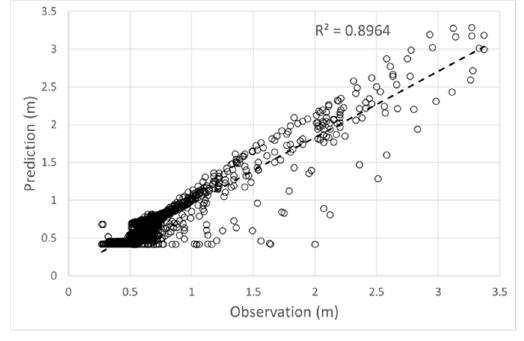
Scatter plot results Figure 10. Waterlevel prediction by deep neural networks (Gurodigital station). ( a ) Vanilla ANN. ( b ) LSTM. ( c ) Stack-LSTM. ( d ) Bidirectional LSTM. Table 5. Comparison and analysis of waterlevel prediction results due to deep learning models.